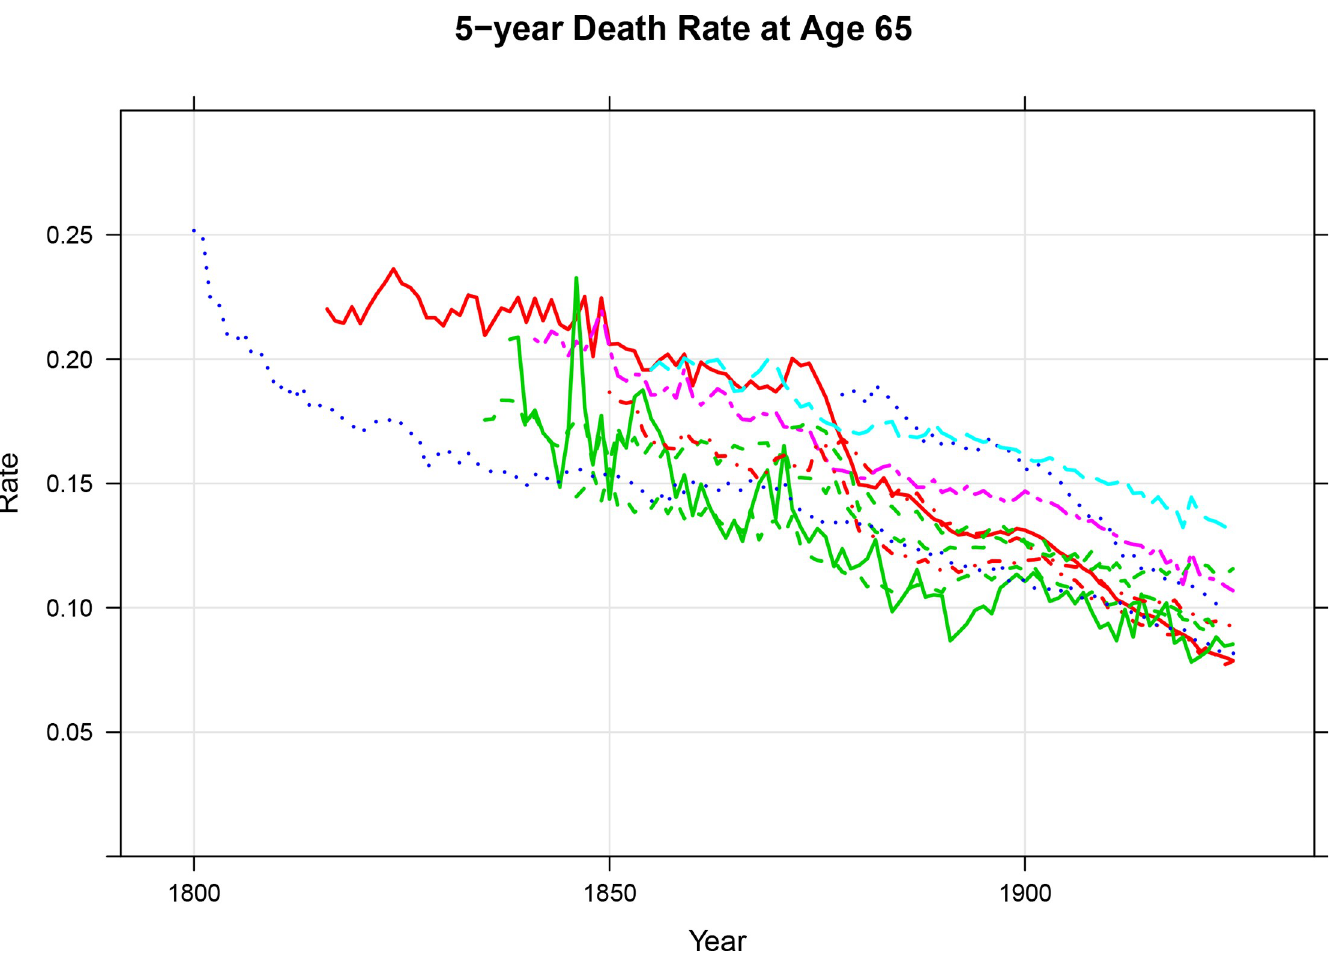
Fig 5. 5-Year death rates at age 65, 1830 to the latest observation, cohort life tables from Denmark, England and Wales, Finland, France, Iceland, Italy, the Netherlands, Norway, Scotland, Sweden, and Switzerland, both sexes combined. Source: Human Mortality Database [9] and Authors’ Calculations. Underlying data are presented in the Supplementary